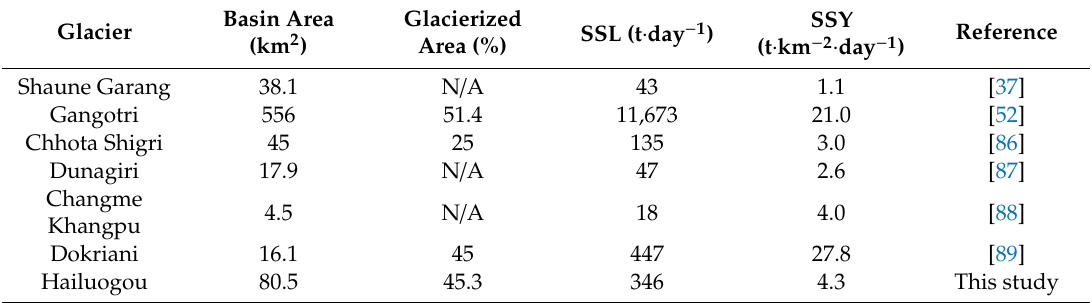
Table 6. Daily mean suspended sediment load (SSL) and yields (SSY) from Hailuogou Glacier in comparison to nearby Himalayan glaciers. N / A denotes data are not